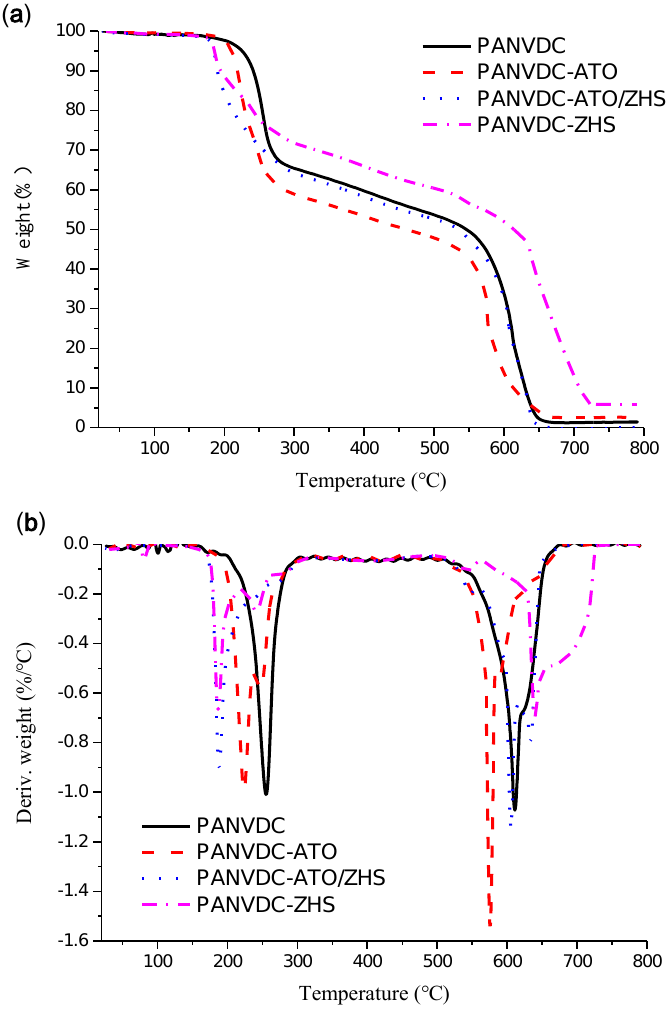
Figure 5. ( a ) Thermogravimetric analysis (TGA) and ( b ) derivative thermogravimetric (DTG) curves of the PANVDC fibers with flame retardants at a heating rate 20 ◦ C / min to 800 ◦ C under air conditions. Table 4. TGA and DTG results of the PANVDC fibers with flame retardants at a heating rate 20 ◦ C / min to 800 ◦ C under air conditions.